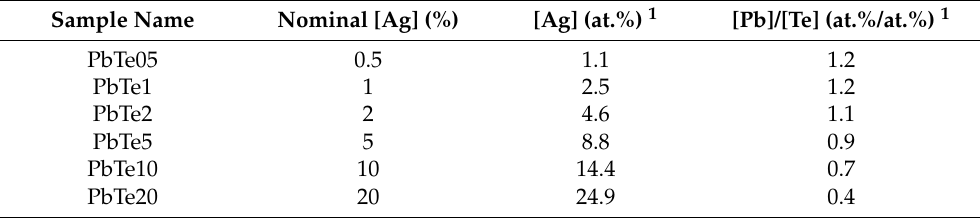
Table 2. Values of the XPS atomic concentration of Ag and Pb/Te atomic ratio for the investigated